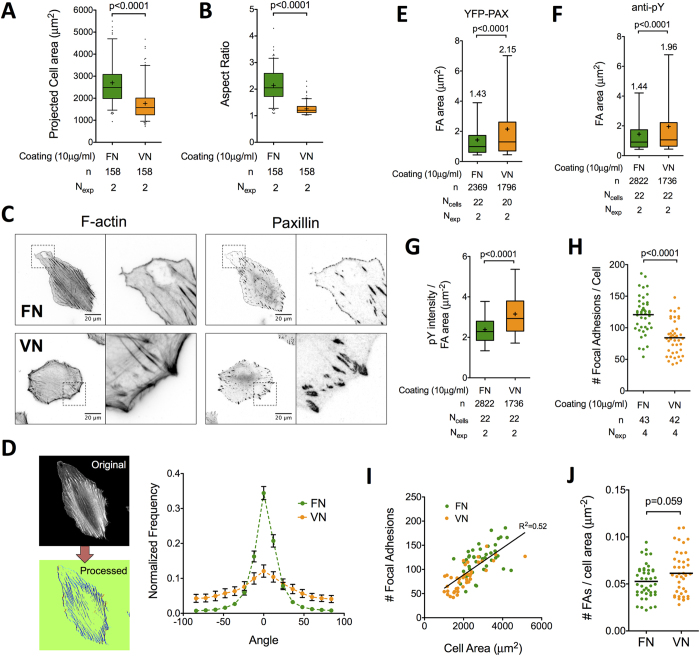
Distinct fibroblast spreading, adhesion plaque organization and cytoskeleton organization on FN versus VN.REFWT projected cell area (A) and aspect ratio (B) 6 hours post-seeding were significantly higher on FN- compared to VN-coated substrates (n: number of analyzed cells). (C) Actin microfilament staining and YFP-PAX localization in REFYFP-PAX 6 hours post-seeding revealed important differences in stress fiber and adhesion plaque organization (see main text for details). (D) Stress fiber orientation was quantified using a custom-written algorithm and showed a high degree of fiber alignment on FN and random orientation on VN (details in the materials & methods section; the 0° angle corresponds to the maximum for each cell; mean and SEM from n > 15 cells and 2 independent experiments are presented). (E,F) FA area quantification based on YFP-paxillin clustering (E) or anti-pY staining (F) revealed formation of larger FAs on VN compared to FN (n: number of FAs; mean values are shown on graph). (G) Quantification of anti-pY fluorescence intensity of FAs normalized to FA area was higher on VN (n: number of FAs from Ncells). (H) Quantification of FA number per cell showed a higher number of FAs present on fibroblasts adhered on FN compared to VN (n: number of cells). However, as the number of FAs per cell was correlated with cell area (I), the difference of FA number per unit cell area was not significant between coatings (J). The middle line in box plots indicates the median, the box indicates the interquartile range, the whiskers the 5th and 95th percentiles and the cross the mean. Black lines in dot plots (H,J) represent mean values. Nexp: number of independent experiments. Experimental data were analyzed using unpaired t-tests.